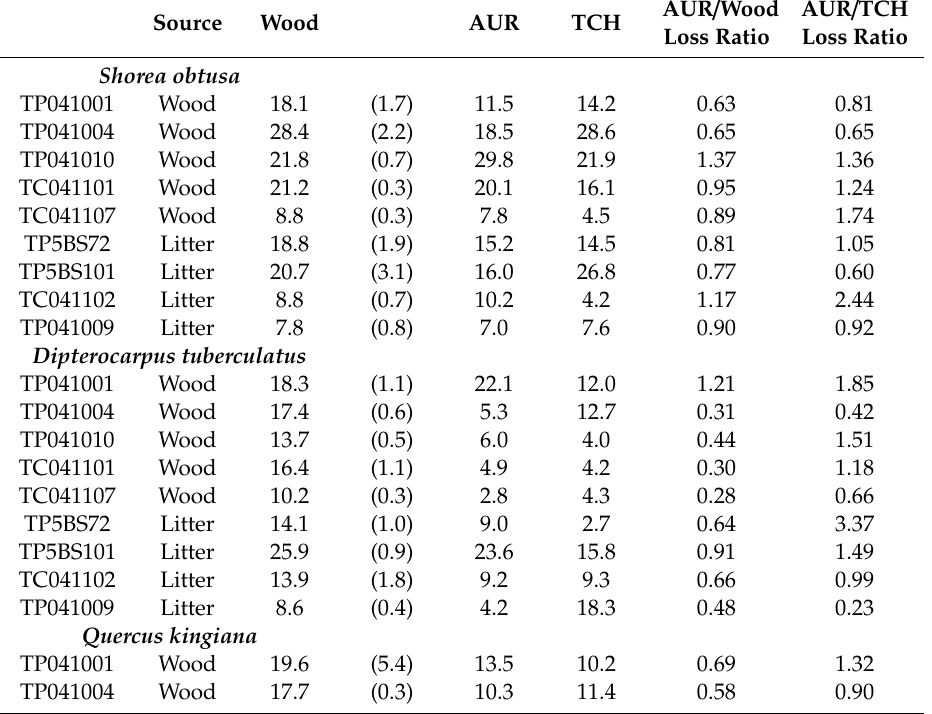
Table 3. Mass loss (% original mass) of wood, acid unhydrolyzable residue (AUR), and total carbohydrates (TCHs), AUR / wood loss ratio, and AUR / TCH loss ratio after 12 weeks at 20 ◦ C when inoculated with Xylaria isolates in vitro. Values of wood mass loss are means with standard errors in parentheses. Data of mass loss of wood were from